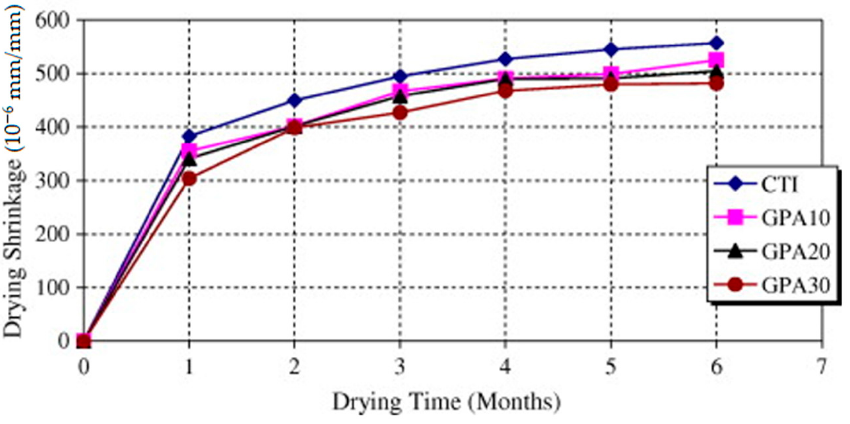
Figure 9. Influence of POFA on the concrete DS [104]. Reprinted with permission from Elsevier